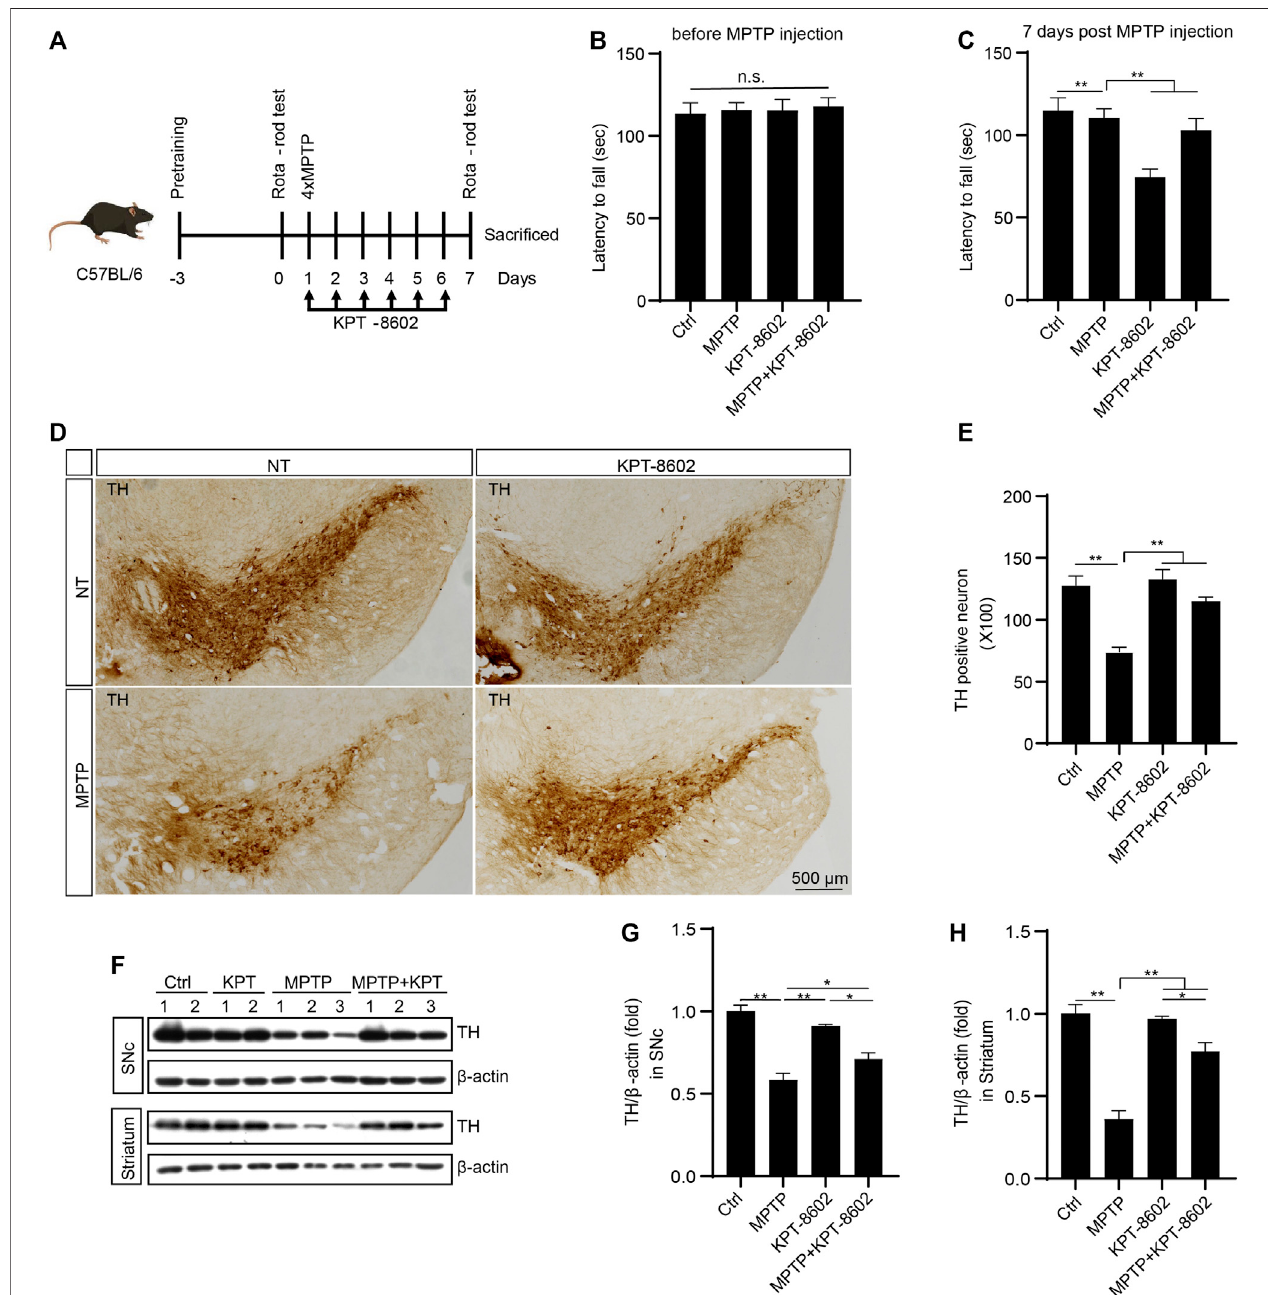
FIGURE 6 | KPT-8602 ameliorates PD model mice severity. C57BL/6 mice were treated with saline or MPTP (four i.p. injections of 20 mg/kg at 2 h intervals). KPT8602(5 mg/kg)orvehiclewereadministereddaily(7micepergroup). (A) ScheduleofthePDmodelestablishmentandadministrationofKPT-8602. (B,C) Latencyof theindicatedmiceontherotarod. (D) Representativephotomicrographsoftyrosinehydroxylase(TH)-stainedsectionsfromthesubstantianigracompacta(SNc)ofmice brain. Scale bars, 500 μ m for images, respectively. (E) Number of TH-positive neurons was analyzed by ImageJ. The expression of TH and β -actin protein was analyzedbyWesternblotting (F) ,andthegrayvalueoftheirbandsintheSNc (G) andstriatum (H) wereanalyzedbyImageJ.(*indicates p < 0.05,**indicates p < 0.01by one-way ANOVA).